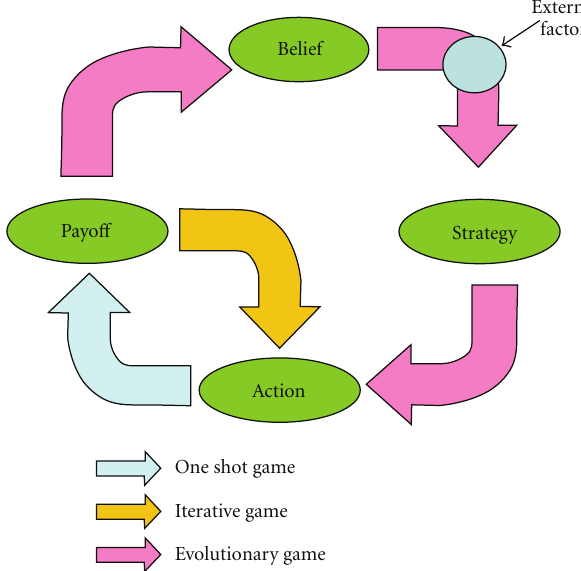
Figure 5: Life cycle of autonomous choice.